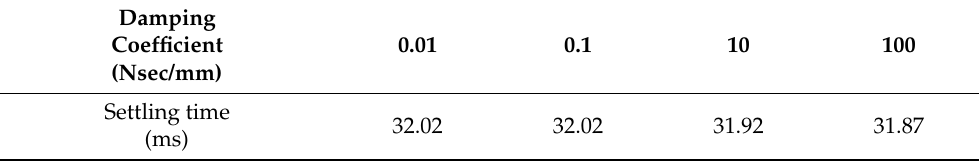
Table 5. Settling time according to damping coefficient.